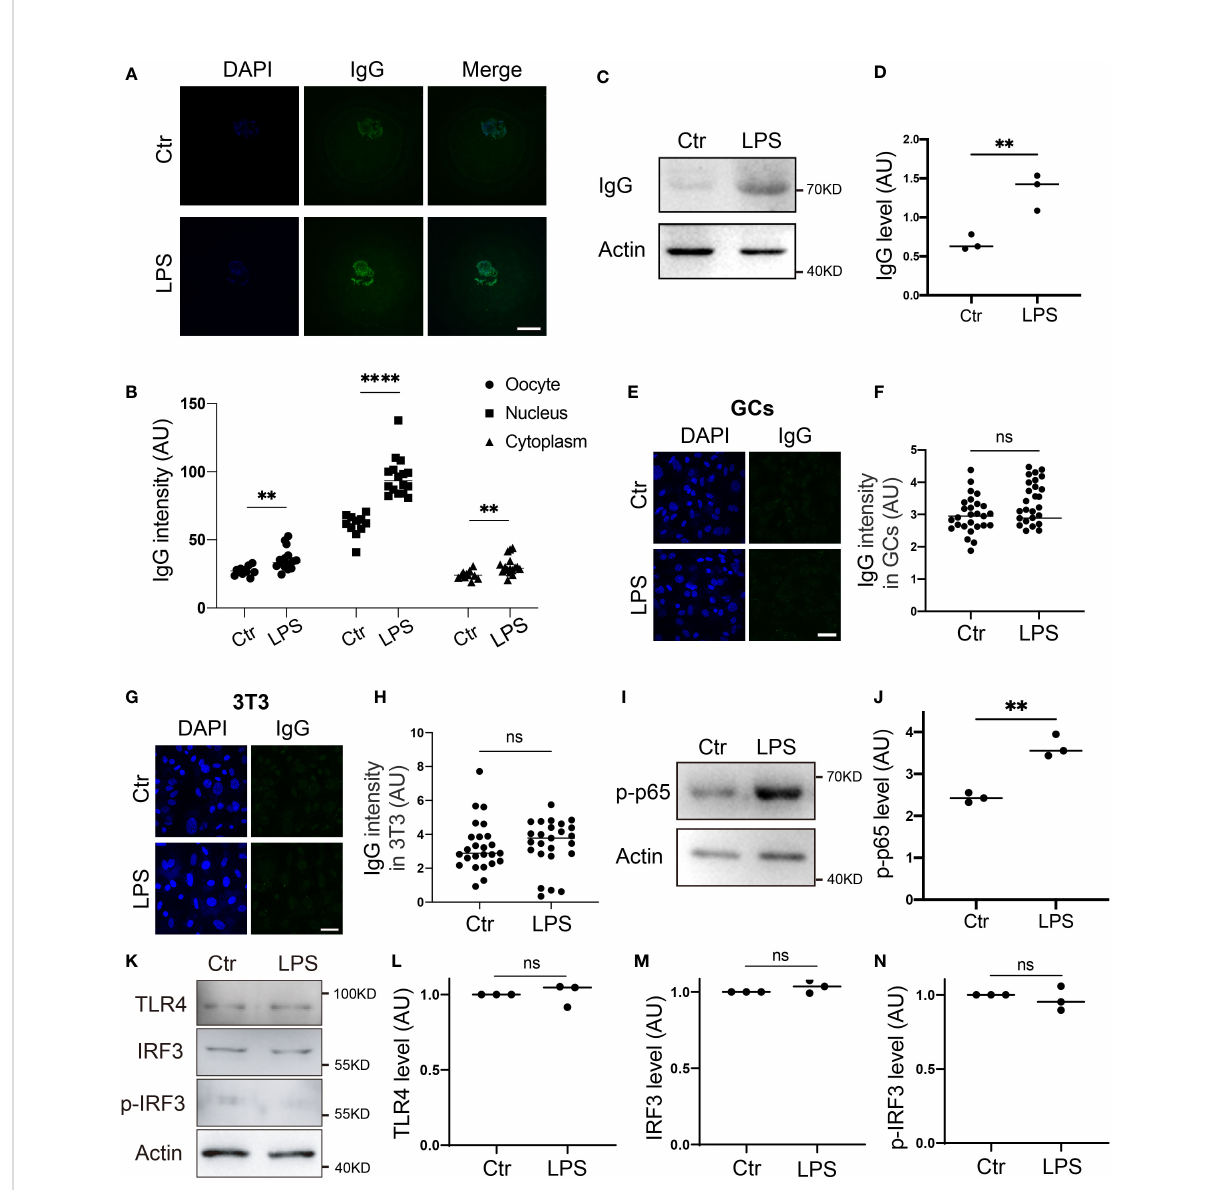
FIGURE 2 IgG protein increased in response to environmental LPS (A, B) Immuno fl uorescence shows that IgG increased more than one-fold in response to LPS, and nuclear IgG increased more signi fi cantly. (C, D) Western blot and quanti fi cation show that IgG protein level increased more than one-fold in response to LPS (Lipopolysaccharide) supplemented in the IVM ( in vitro maturation) medium. (E-H) Immuno fl uorescence shows that IgG intensity is very low in control granular cells (GCs), (E, F) or NIH3T3 (3T3s), (G, H) and did not increase at all on exposure to LPS stimuli. (I, J) Western blot and quanti fi cation show that p-NFKB (p-p65) signi fi cantly increased in response to LPS. (K-N) . Western blot and quanti fi cation show that TLR4, IRF3, and p- IRF3 didn ’ t change at all in response to LPS. Actin was used as a loading control. Scale bars, 20 m m. ** indicates p < 0.01. **** indicates p < 0.0001. ns, not signi fi